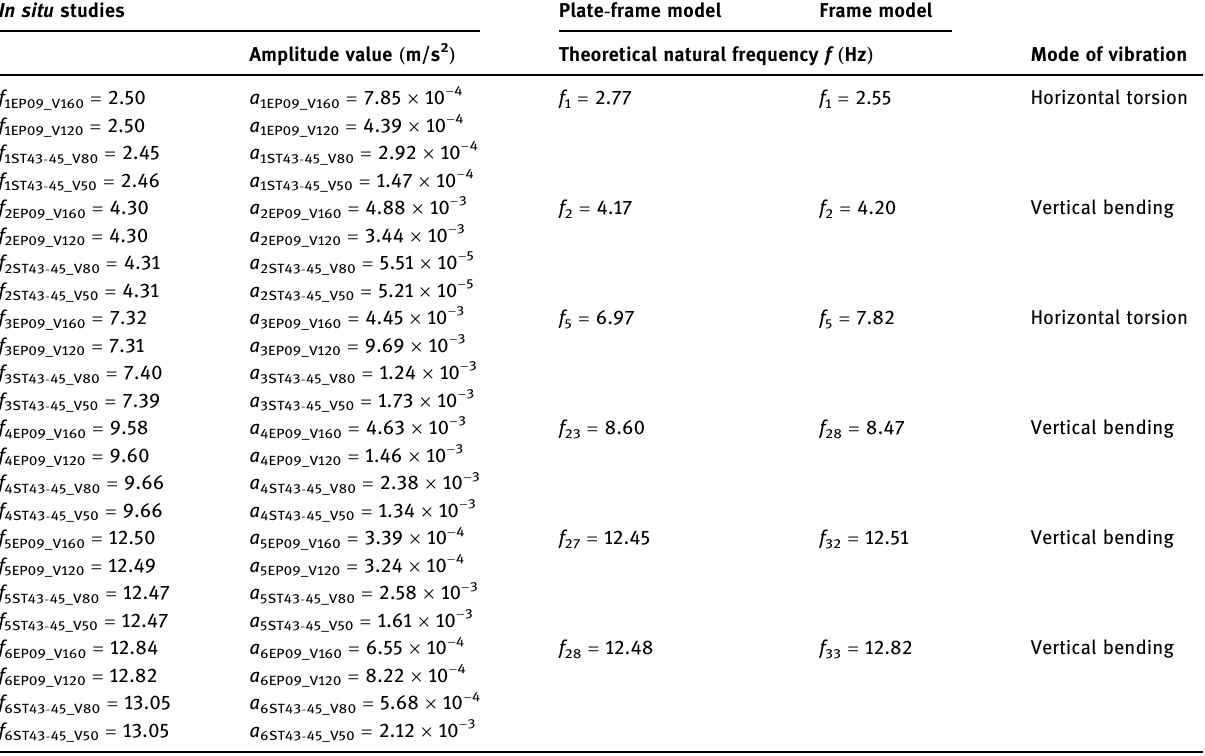
Table 4: Comparative analysis of the results of the bridge span natural frequencies obtained in the theoretical and physical studies In situ studies